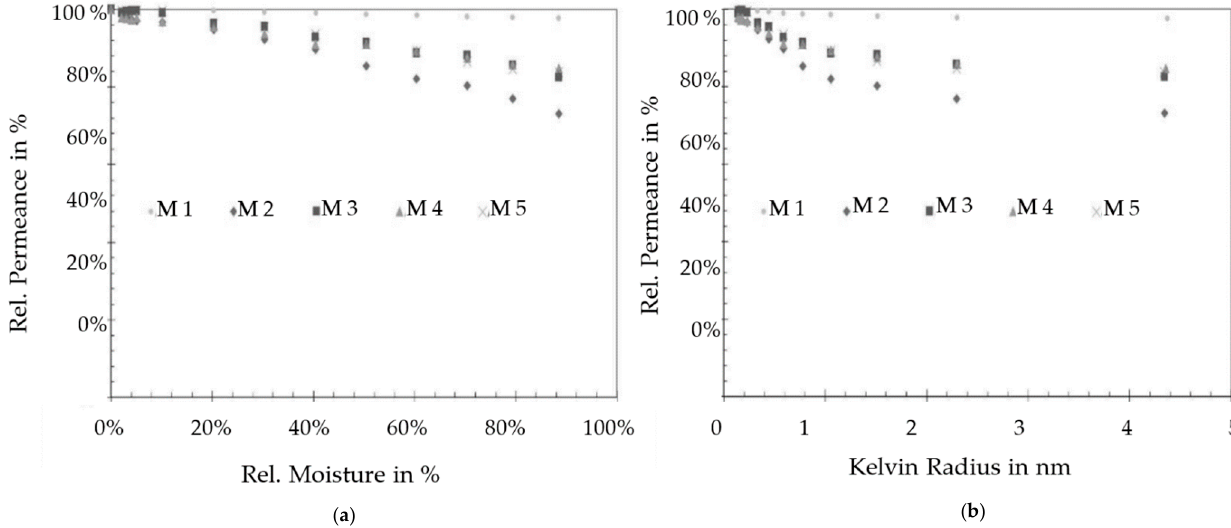
Figure 7. Relative permeance of a hybrid membrane as a function of ( a ) the relative moisture of the nitrogen gas flowing through the pores; ( b ) the calculated Kelvin radius of the pores.